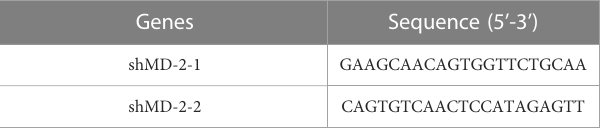
TABLE 2 The sequences of shMD-2 and shTLR4.